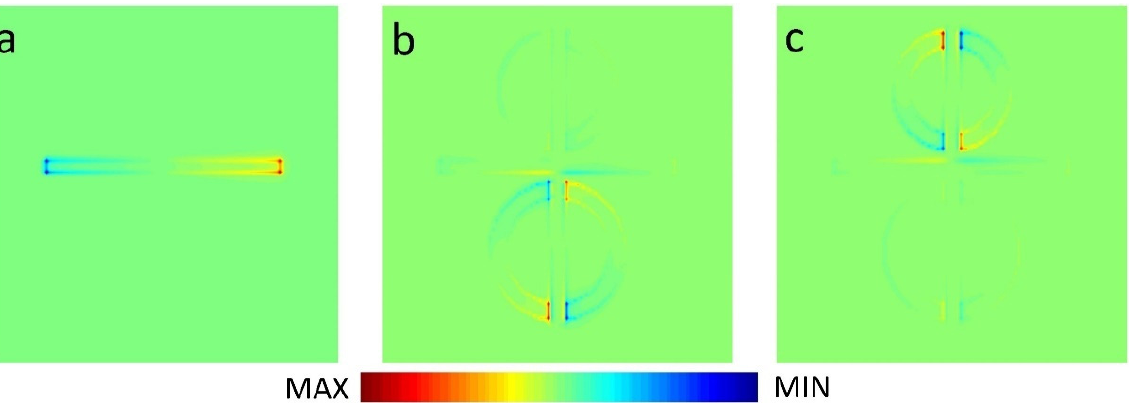
Figure 3. Electric field distributions of ( a ) the CW, ( b ) the PIT metamaterials at 0.873 THz, and ( c ) the PIT metamaterials at 1.016 THz.